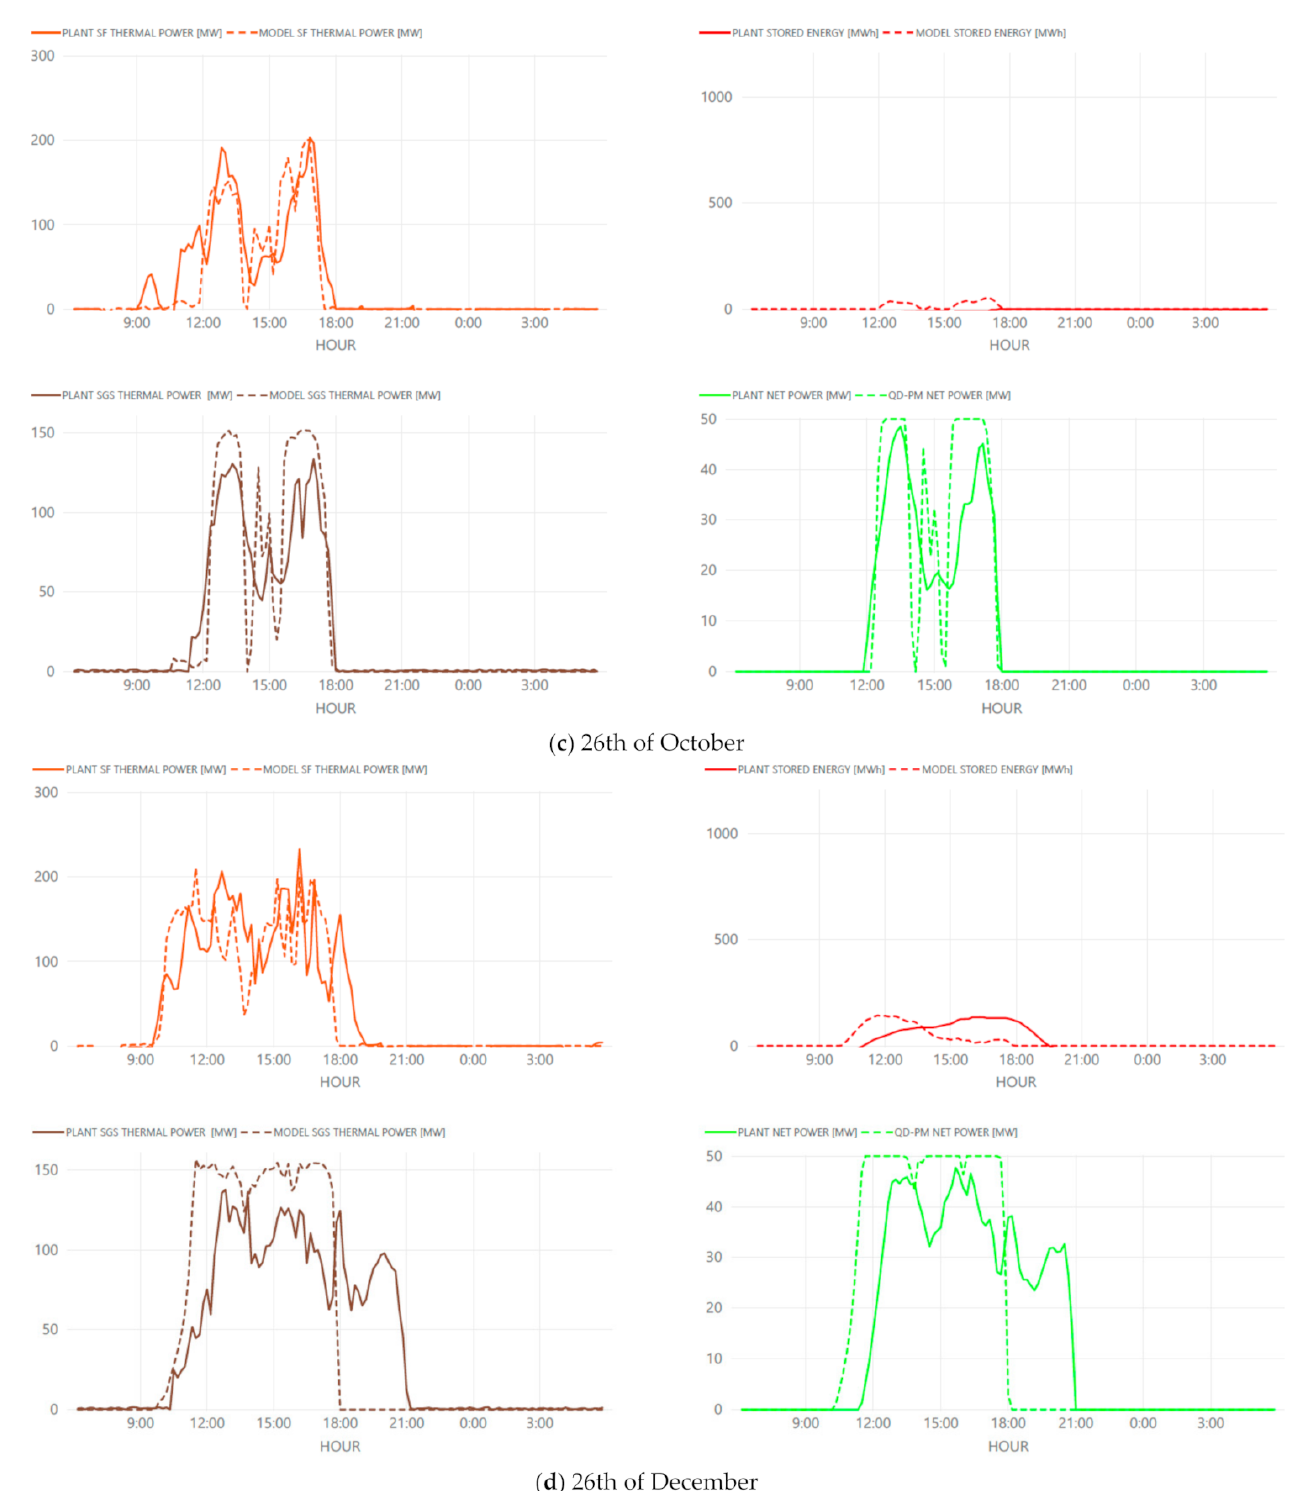
Figure 14. Samples of daily comparison between QD-PM and measured data ( a ) 26th April; ( b ) 26th August; ( c ) 26th October; ( d ) 26th